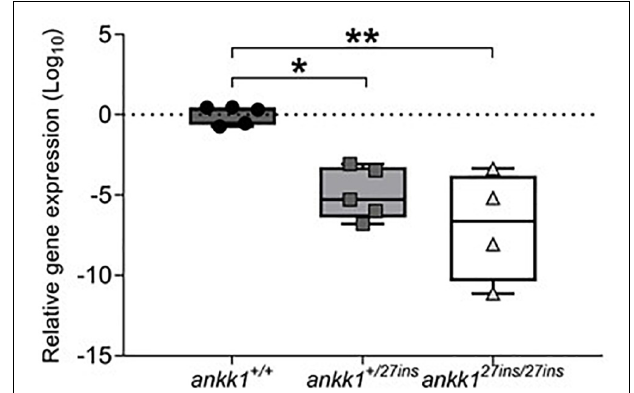
FIGURE 2 | Depletion of mRNA transcripts in 5 days post fertilization zebrafish larvae. ankk1 + / + (dark gray), ankk1 + / 27 ins (gray), and ankk1 27 ins / 27 ins (white). Data shows box and whiskers (5–95 percentile) and single samples (dots, squares, or triangles). Horizontal lines indicate group mean. Legend: * p ≤ 0.05, ** p ≤